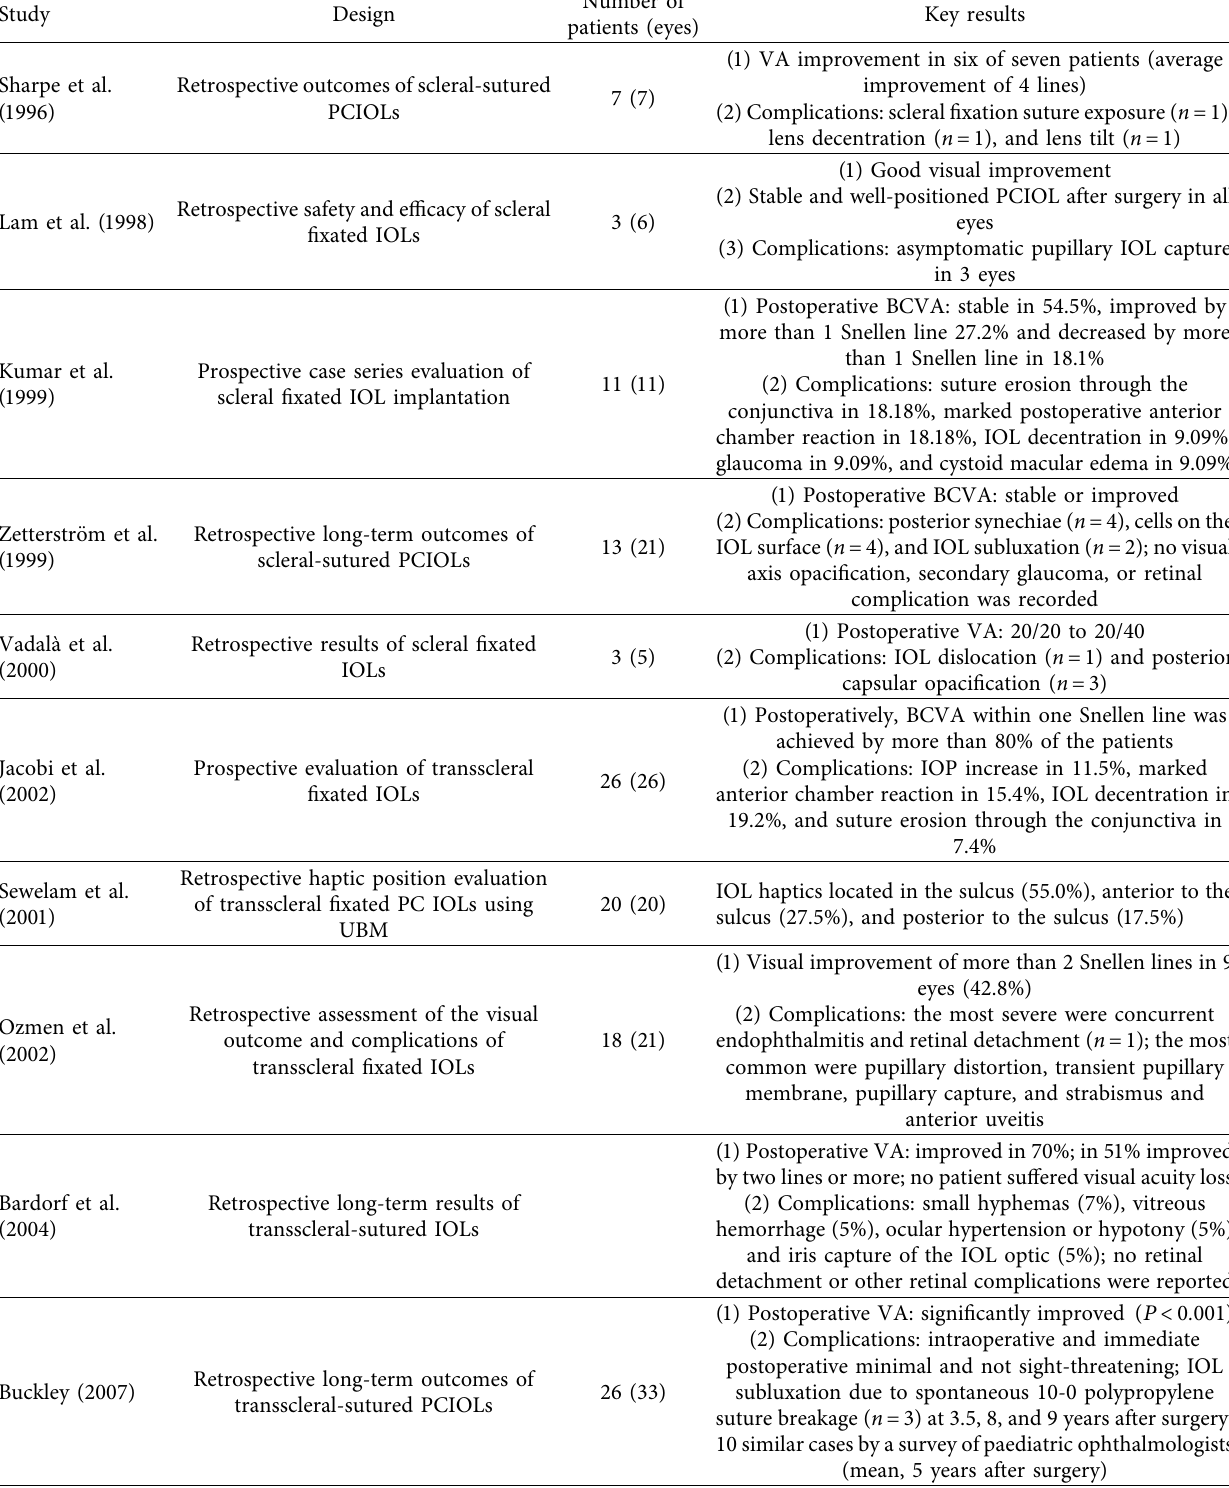
Table 1: The most important studies of scleral-sutured IOLs in paediatric